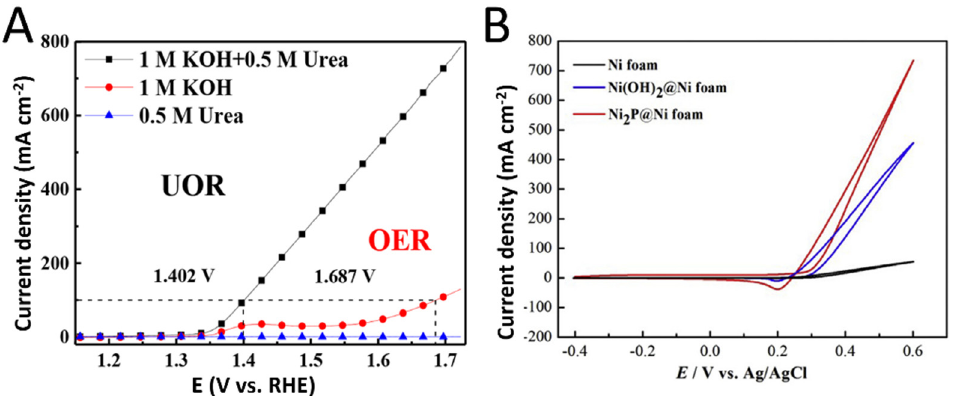
Figure 6. ( A ) LSVs of materials in 1.0 M KOH with 0.5 M urea [102]. Reproduced with permission [102]. Copyright 2020, American Chemical Society. ( B ) CVs of different electrodes in 5.00 M KOH solution with M urea [105]. Reproduced with permission [105]. Copyright 2018, Hydrogen energy Publication LLC. Published by Elsevier Ltd.